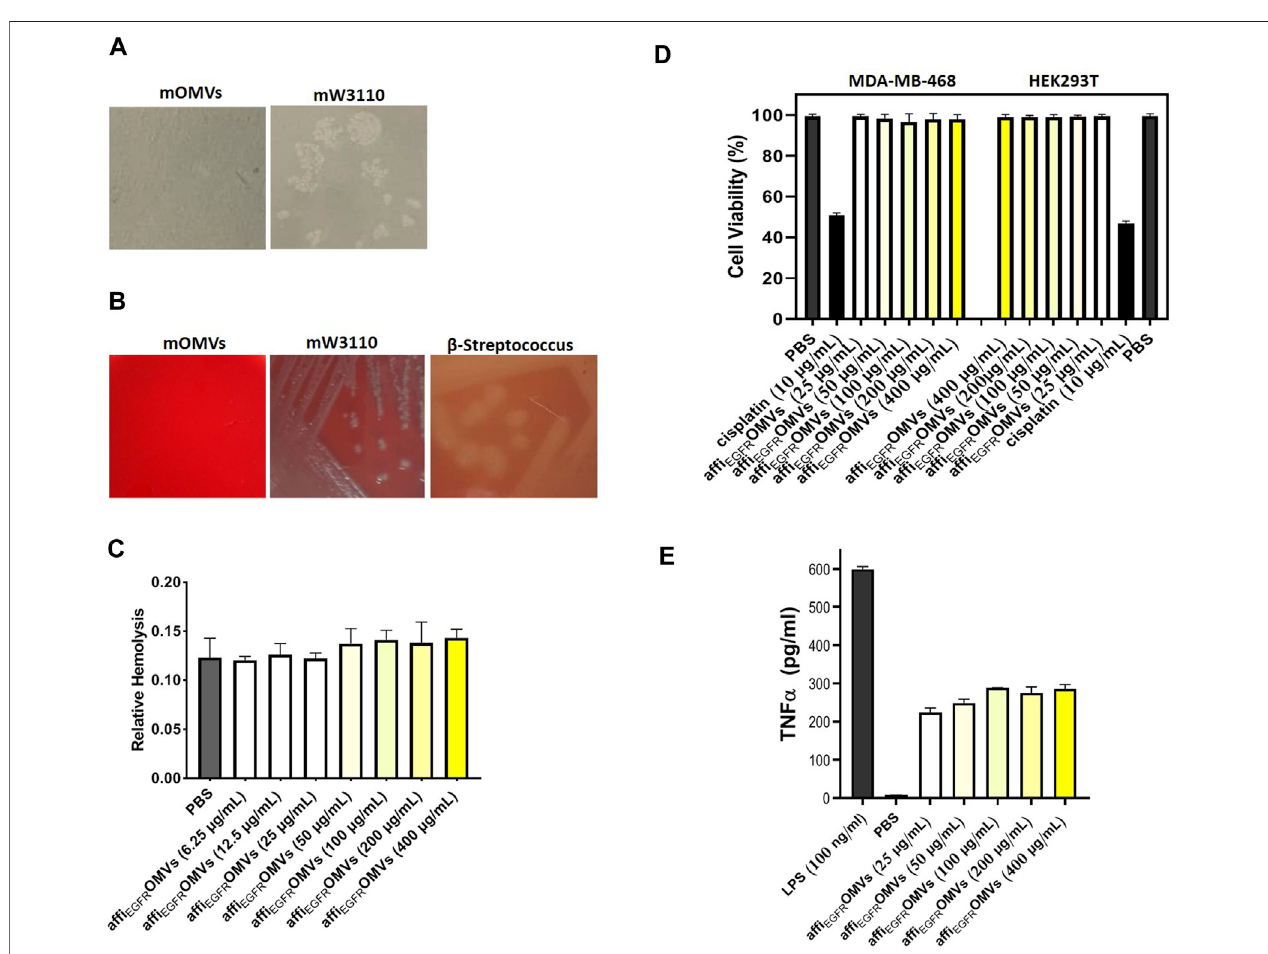
FIGURE 8 | In vitro cytotoxicity, hemolytic activity, and immune stimulation assessments of the af fi EGFR -OMVs. (A) No bacterial growth was seen on LB-agar plate cultured with the engineered OMVs (mOMVs), con fi rming sterility of the OMV sample. (B) Lack of hemolytic activity in af fi EGFR -OMVs (mOMVs) by plating them on horse blood agar plates.A clear zone due tothe red blood cell lysis wasapparentin the β - streptococcus plate(positive control),whereas no lysis wasobservedin the bacteria and theirderived af fi EGFR -OMVs. (C) Liquidehemolytic activity testshowednoerythrocytelysisoftheengineeredOMVs. (D) Percentage ofthecellviabilityinMDA- MB-468 and HEK293T cells, 72 h after treatment with af fi EGFR -OMVs (mOMVs), no signi fi cant difference was observed in cell viability when treated with mOMVs and PBS as a negative control. Cisplatin (10 µg/ml) was used as a positive control. (E) TNF- α secretion from the THP1 cells was quanti fi ed by ELISA. The TNF- α level was signi fi cantly higher in the THP1 cells treated with LPS (100 ng/ml) than that of the cells treated with af fi EGFR